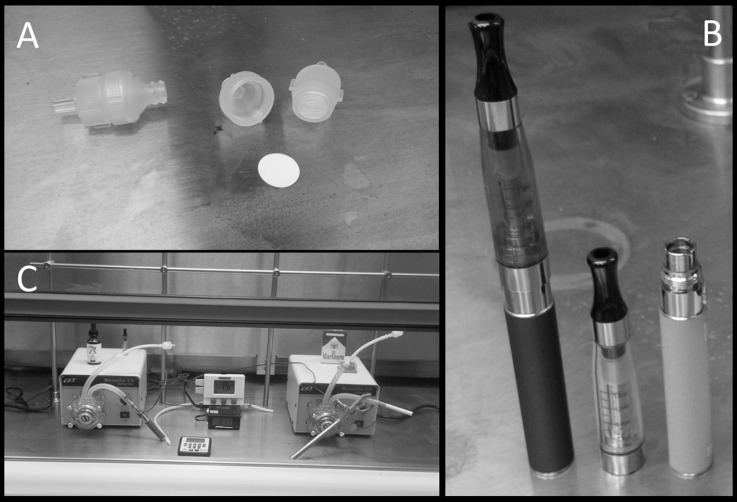
Equipment used in the puffing protocol include (A) Swinnex™ type filter holders and a Millipore Mixed Cellulose Ester (MCE) membrane, (B) Triple 3 eGo electronic cigarettes, and (C) peristaltic pumps in a Thermo Scientific Hamilton SafeAire II laminar flow hood.